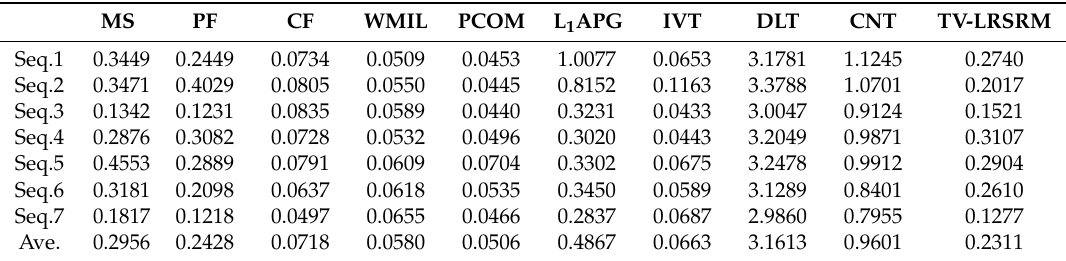
Table 3. Running time (in second) of each